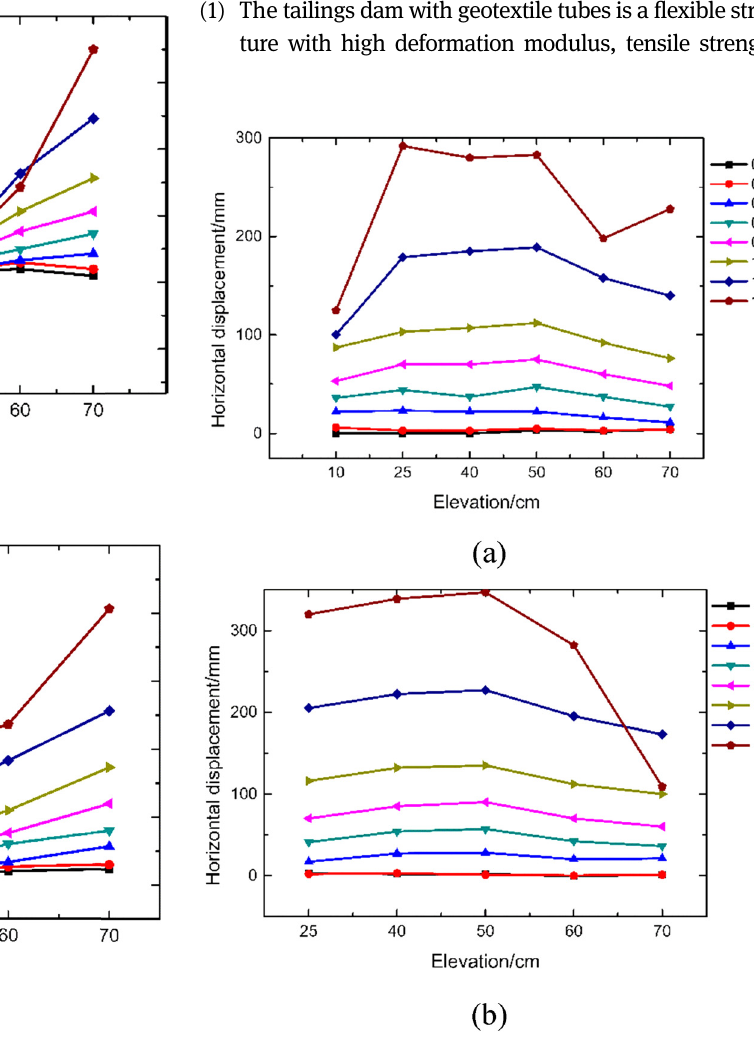
Figure 20: Horizontal displacement of geotextile tubes along ele - vation: ( a ) side A and ( b ) side